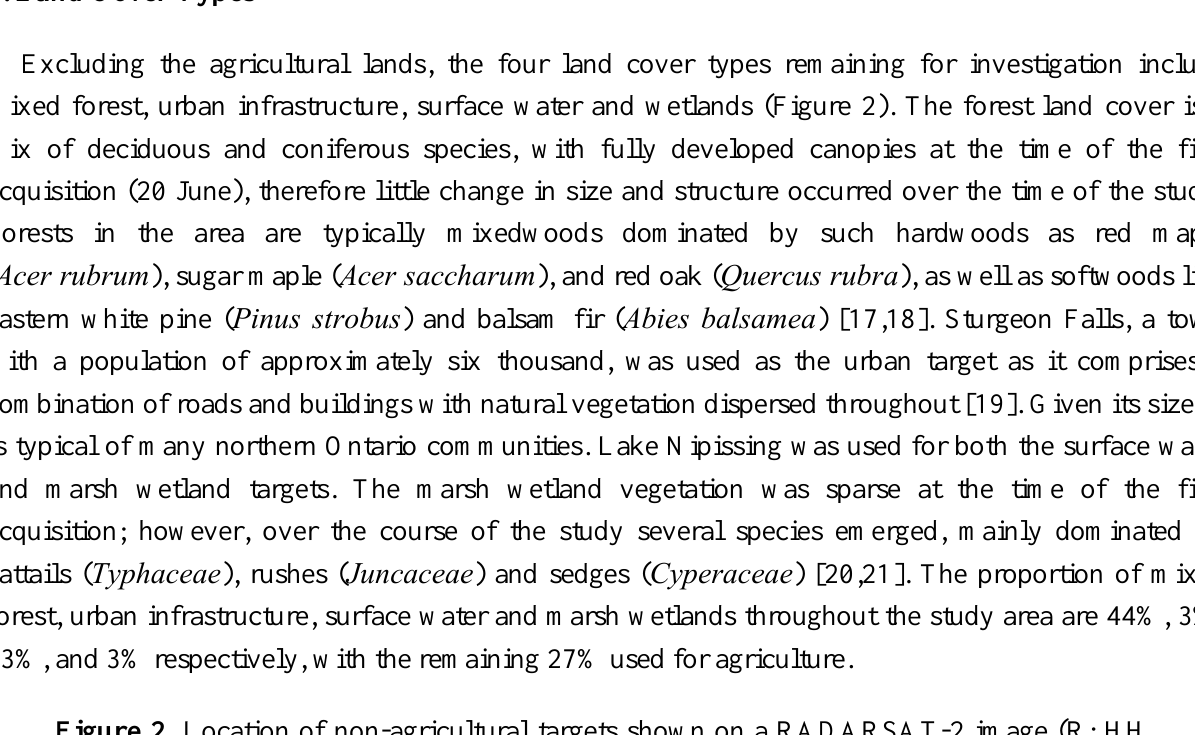
Figure 2. Location of non-agricultural targets shown on a RADARSAT-2 image (R: HH, G: HV, B: VV) taken 4 August 2011 in West Nipissing,